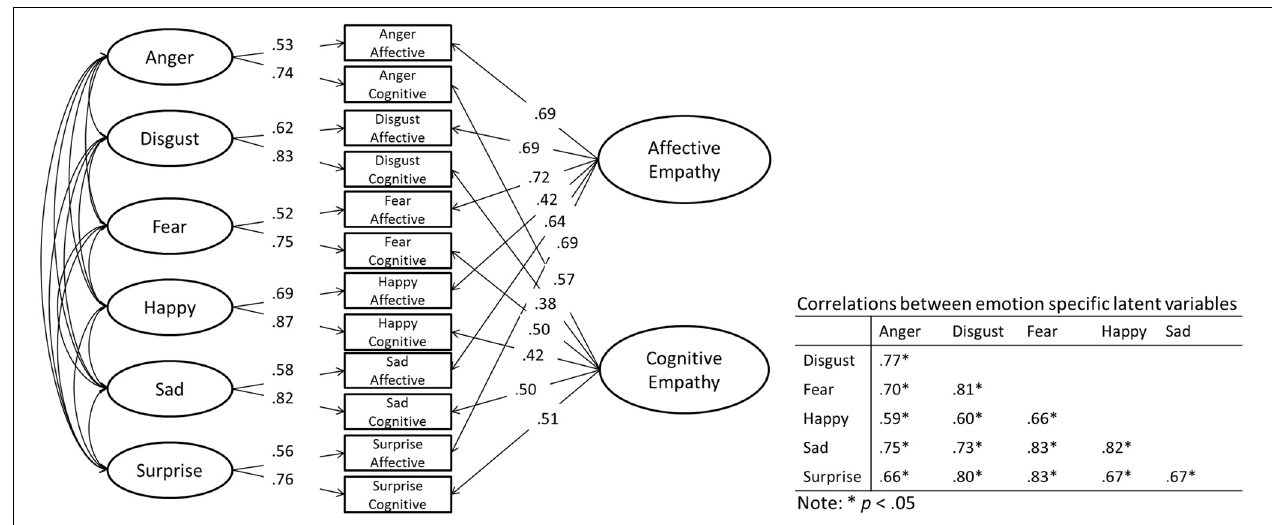
FIGURE 2 | Final ESE Measurement Model (Model